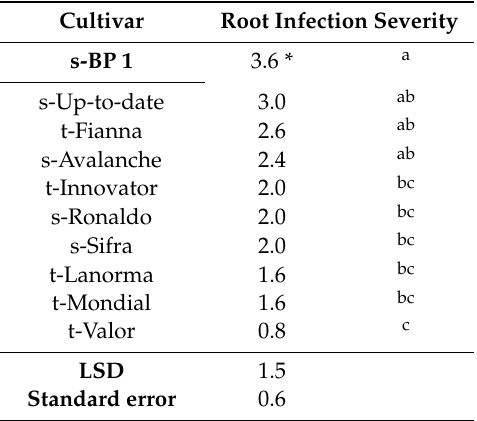
Table 1. Zoosporangia root infection severity of 10 potato cultivars inoculated with Spongospora subterranea f. sp. subterranea.